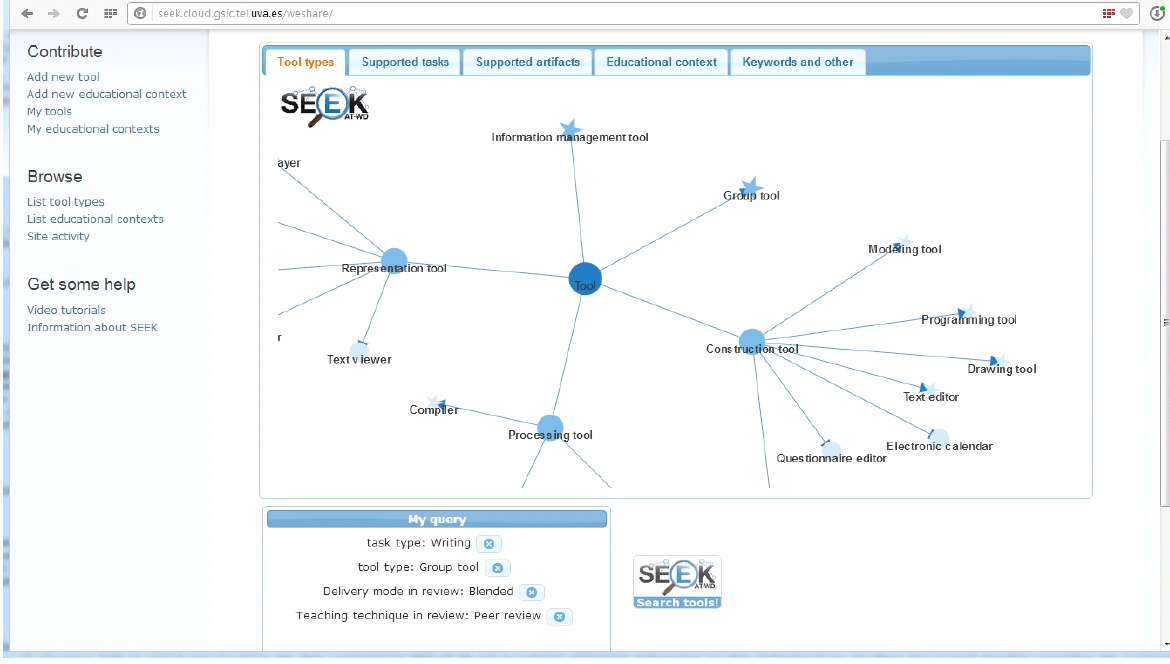
Figure 3. Snapshot of the search interface of